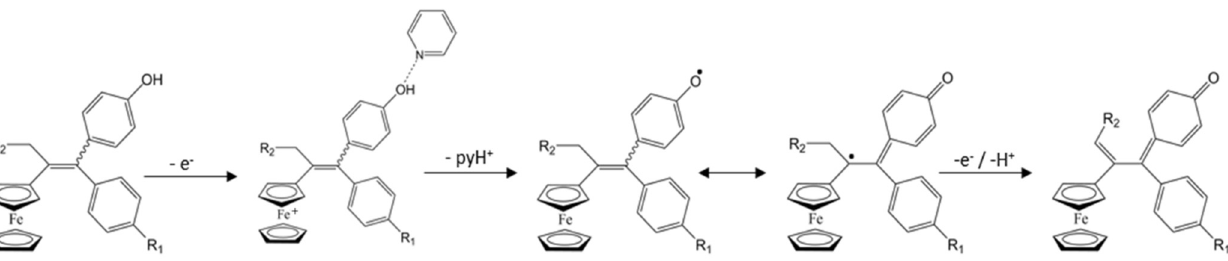
Figure 3. Mechanism of quinone methide formation from ferrocifen. This mechanism was confirmed by electrochemistry and electron paramagnetic resonance. Table 1. Structure of P5, P15, P53, DP1 and P722 ferrocifens and their corresponding quinone methides.